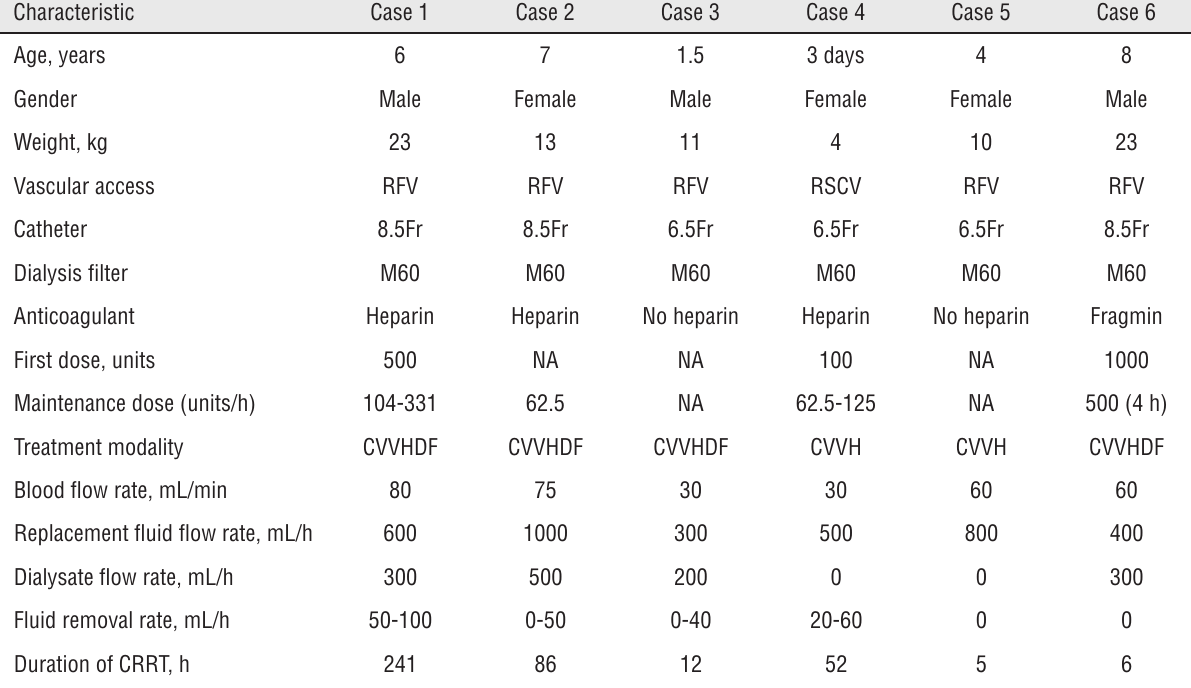
Table 1 - Demographic and treatment characteristics of critically ill children with multiple organ dysfunction syndrome who received continuous renal replacement